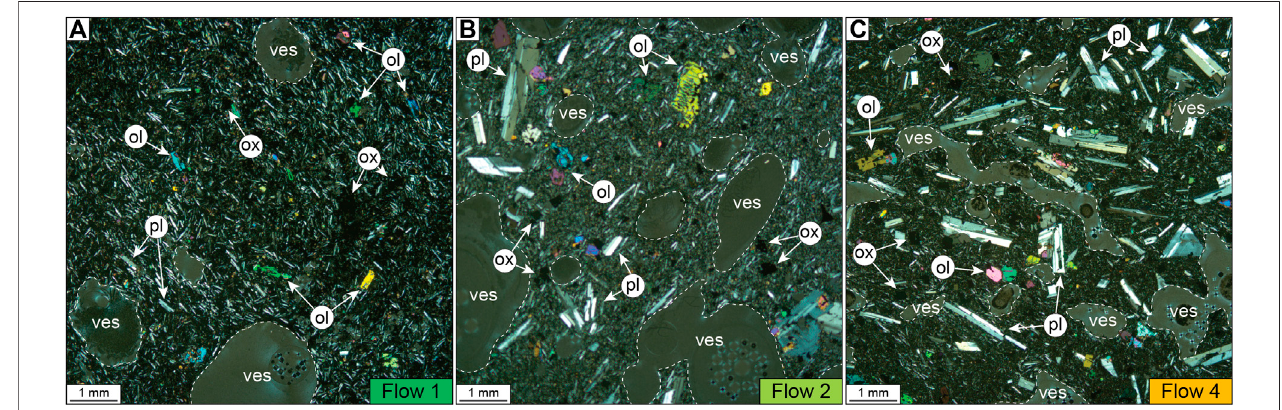
FIGURE7| Representativecross-polarizedphotomicrographsofTseaxlavas.NotetheincreasingamountofphenocrystsfromFlow1toFlow4.Abbreviations:ol, olivine; ox, titanomagnetite; pl, plagioclase; ves, vesicle.